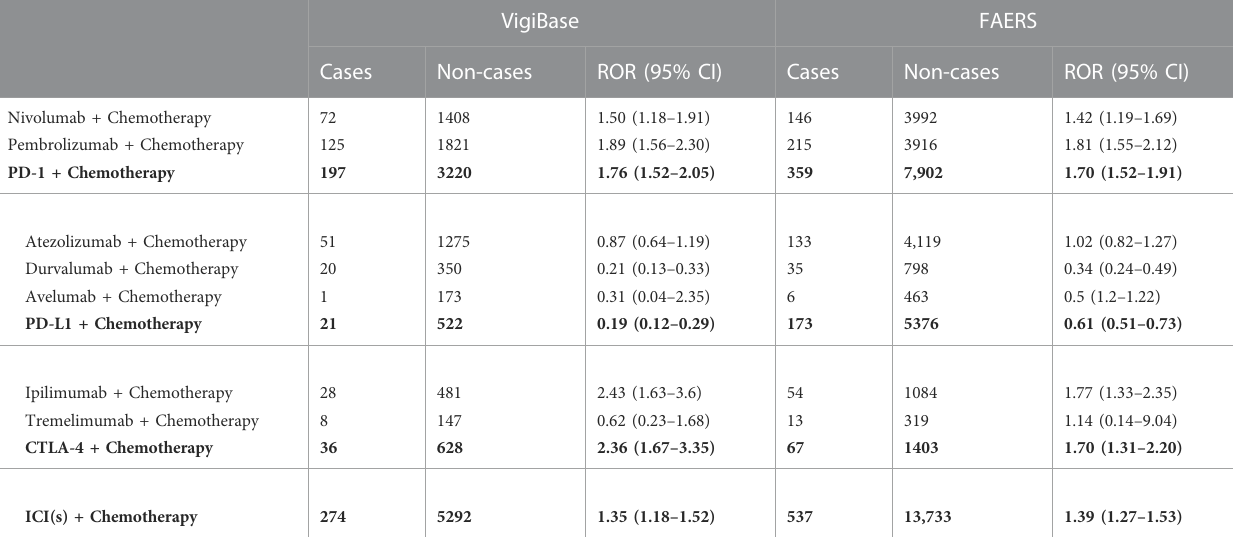
TABLE 2 The disproportionality analysis of patients with ICI plus chemotherapy and ICI in other drug regimens in VigiBase and FAERS databases.